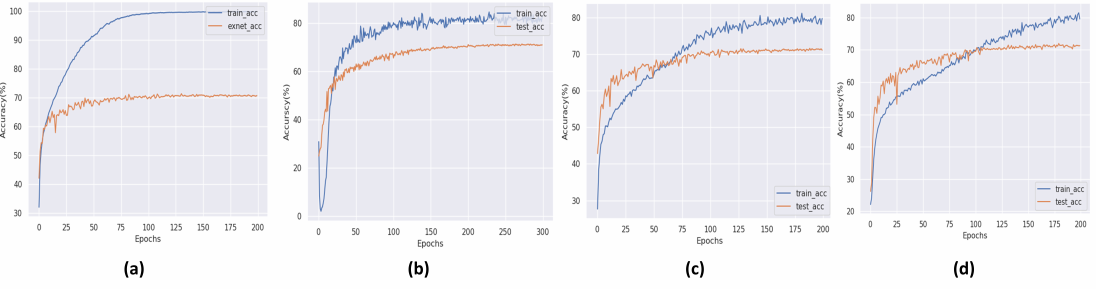
Figure 3. Performance of eXnet on the FER-2013 dataset.